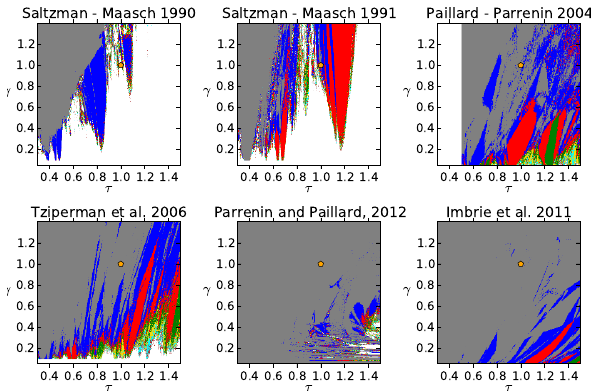
Fig. 16. As Fig. 13 but for 6 models previously published. Orange dots correspond to standard (published) parameters of these models.